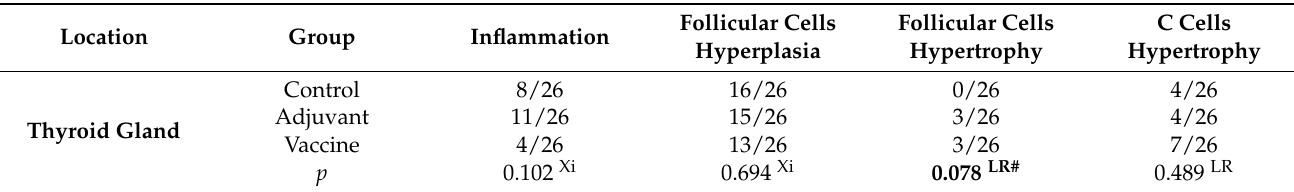
Table A20. Histopathological findings in the thyroid